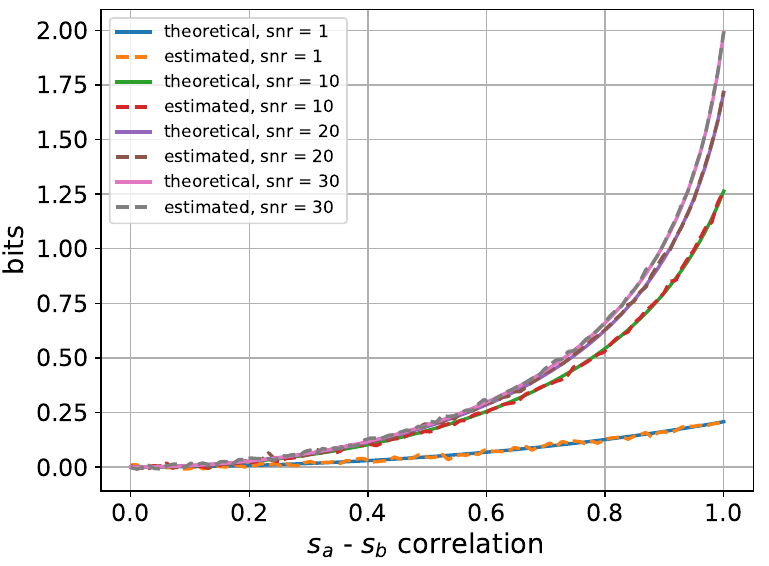
Figure 5. Comparison between the theoretical and estimated mutual information in the correlated Gaussian case, with different SNR